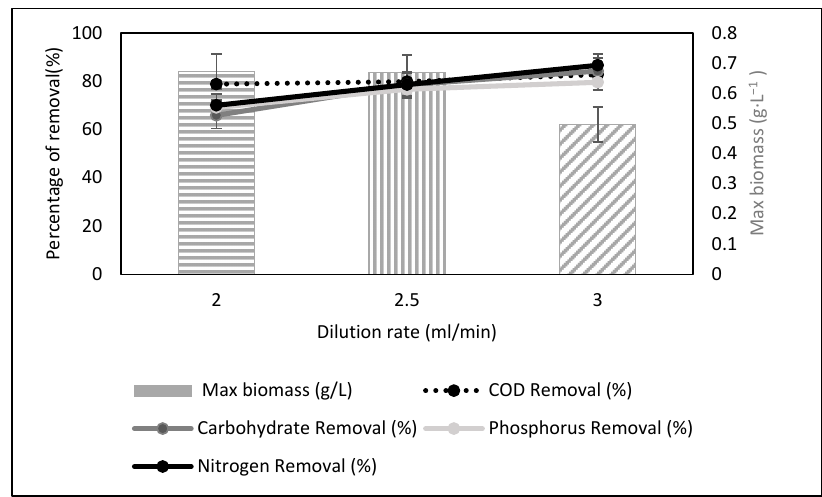
Figure 6. Physicochemical characteristics of treated raw leachate after continuous cultivation.